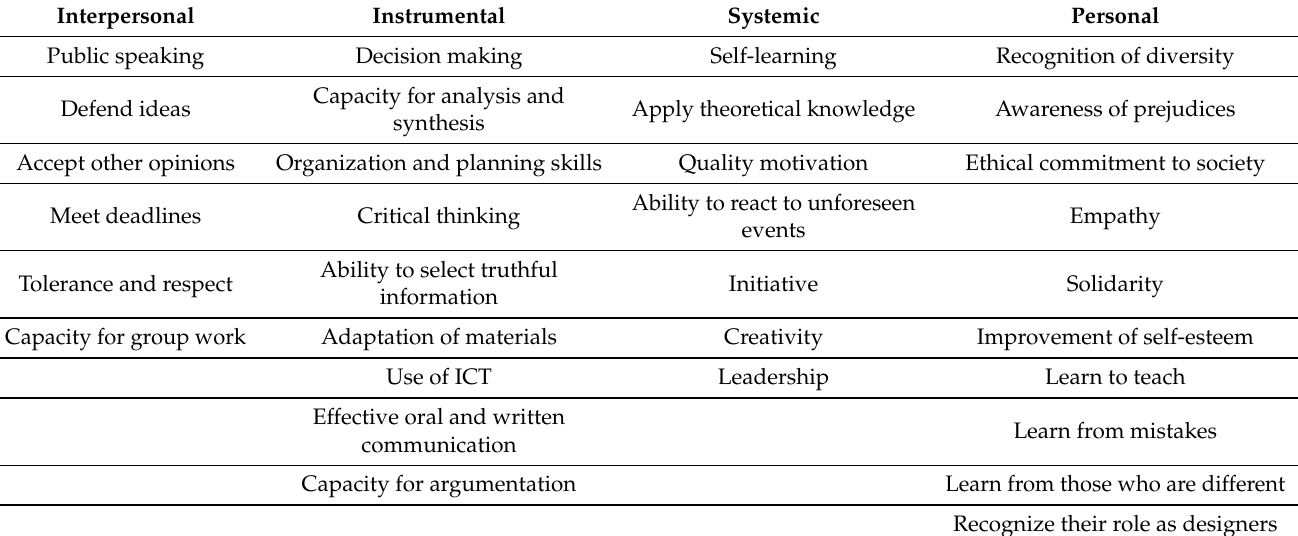
Table 5. Transversal competences and social skills achieved by the SL